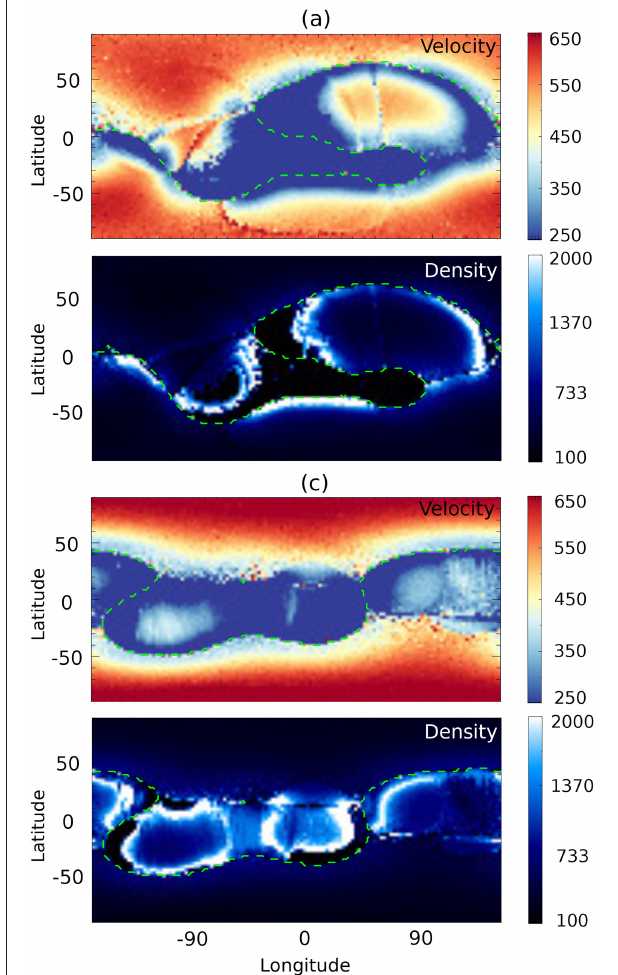
FIGURE 10 | Maps of the velocity (in km / s) and density (in cm − 3 ) of the solar wind at r = 21.5 R ⊙ corresponding to (A,C) in Figures 7 , 8 . The green dashed lines indicate the position of the polarity inversion